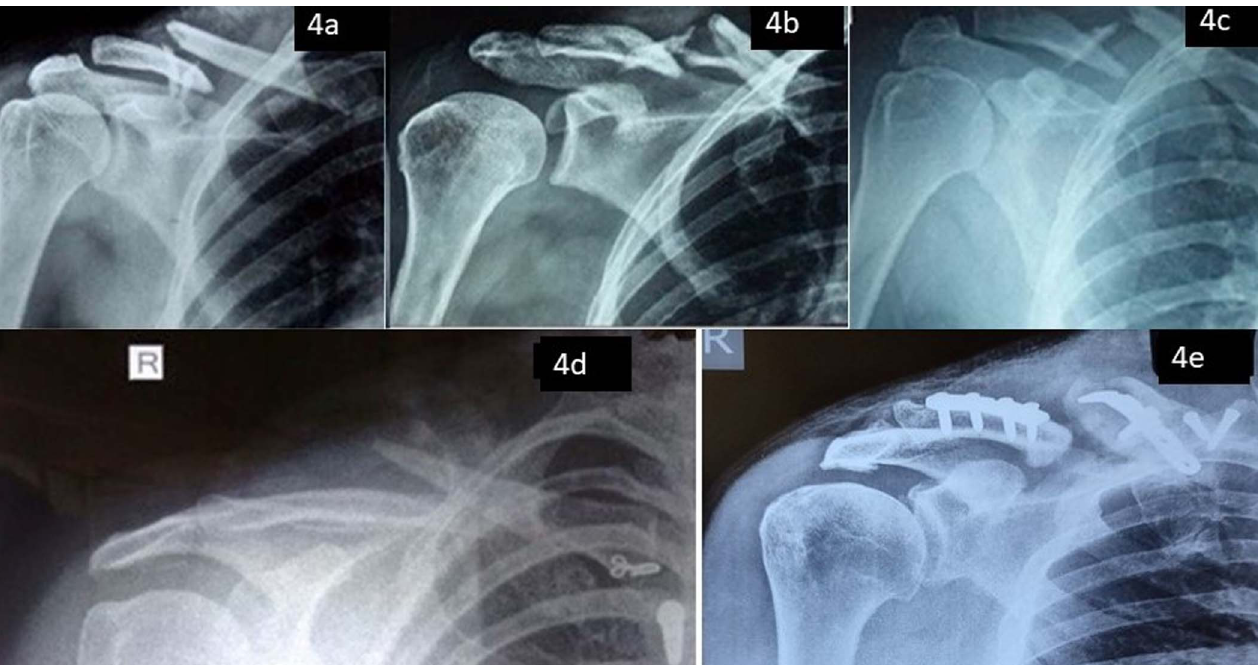
Figure 4. (a) – (c) Preoperative radiographs of fractures with non-union (4d) Nonunion after non-operative treatment (b) Nonunion after operative management.